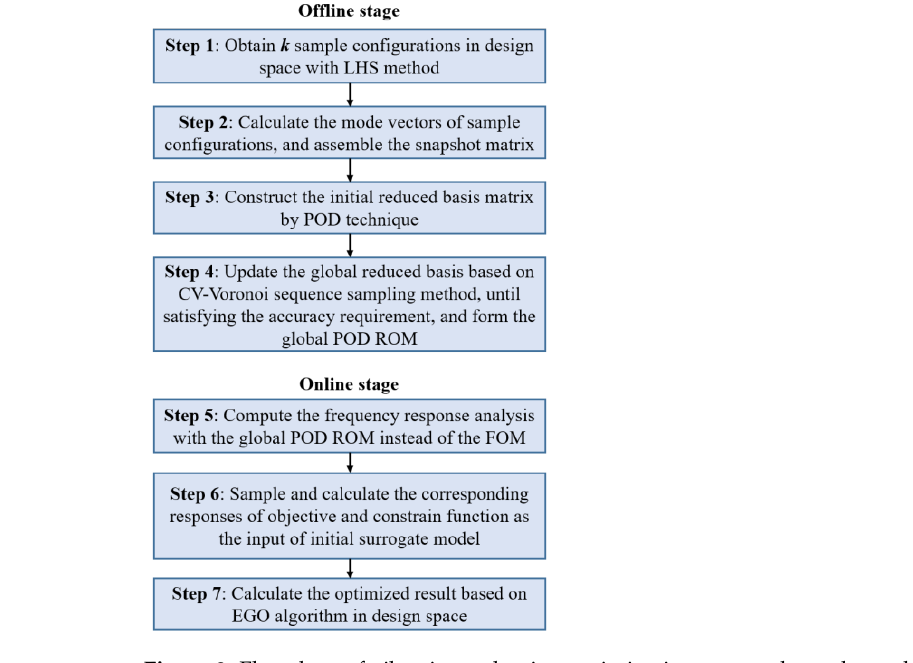
Figure 3. Flowchart of vibration reduction optimization approach accelerated by global POD ROM.